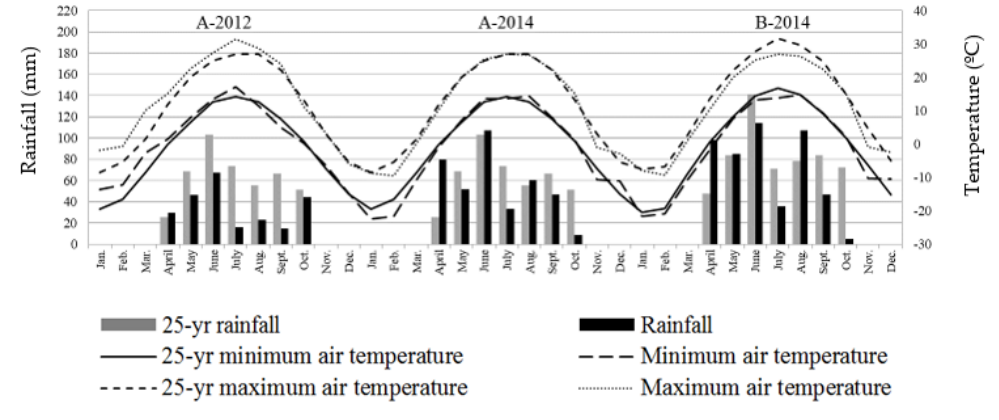
Figure 1. Monthly average minimum and maximum air temperatures and monthly total rainfall in 2012, and 2014 compared with the 25-year (1990–2014) average in Prosper (A), and Walcott (B) [40]. Regression analysis of yield response to N was conducted on relative values to account for magnitude di ff erences among environments. Leaf and root / stem yield, leaf + root / stem) dead matter yield and total biomass yield (leaf + root / stem + dead matter biomass yield) showed linear response with increasing N rates (0, 50, 100, 150, and 200 kg N ha −1 ) ( Figure 2; Figure 3). These increments in forage yield with increased N rates are in accord with Chakwizira et al. [41], who reported a linear response in forage yield of brassicas to N rates up to 200 kg N ha −1 . Other authors also reported increments in yield with increasing N rates [42,43]; however, these authors found quadratic response instead of the linear response observed in the present study. In most of the cases, the di ff erence in biomass yield between the highest N rate (200 kg N ha −1 ) and the lowest (0 kg N ha −1 ) was between 15% for dead matter yield and 23% for leaf yield.